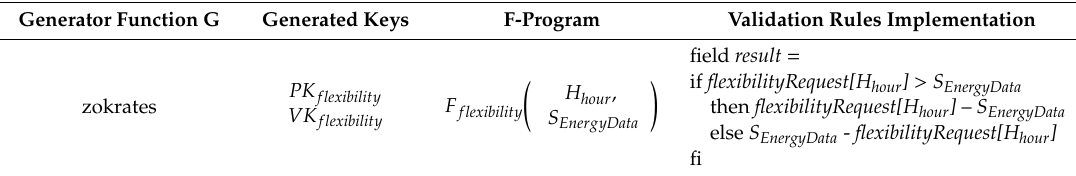
Table 1. Generator function for ZK proofs in DR